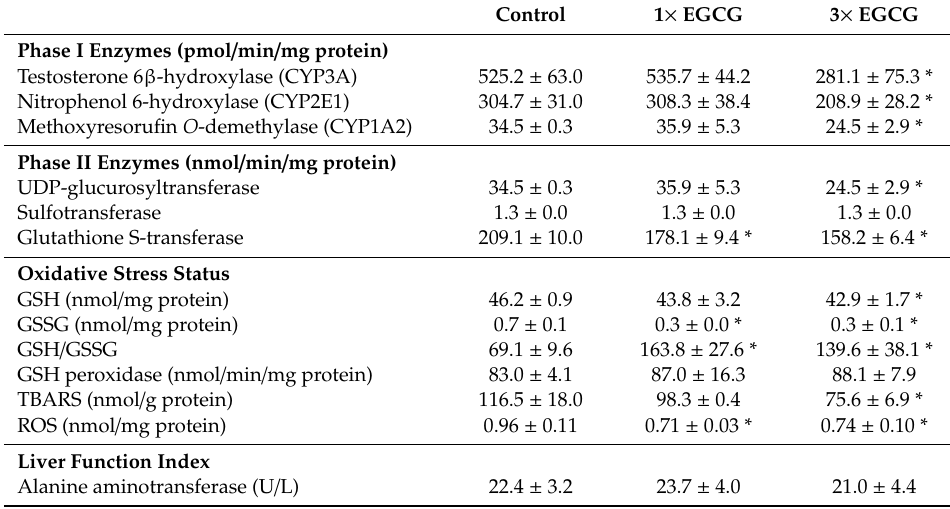
Table 1. Drug-metabolizing enzyme activities, oxidative stress, and liver function index in the liver of rats fed EGCG-containing diets for four weeks a .